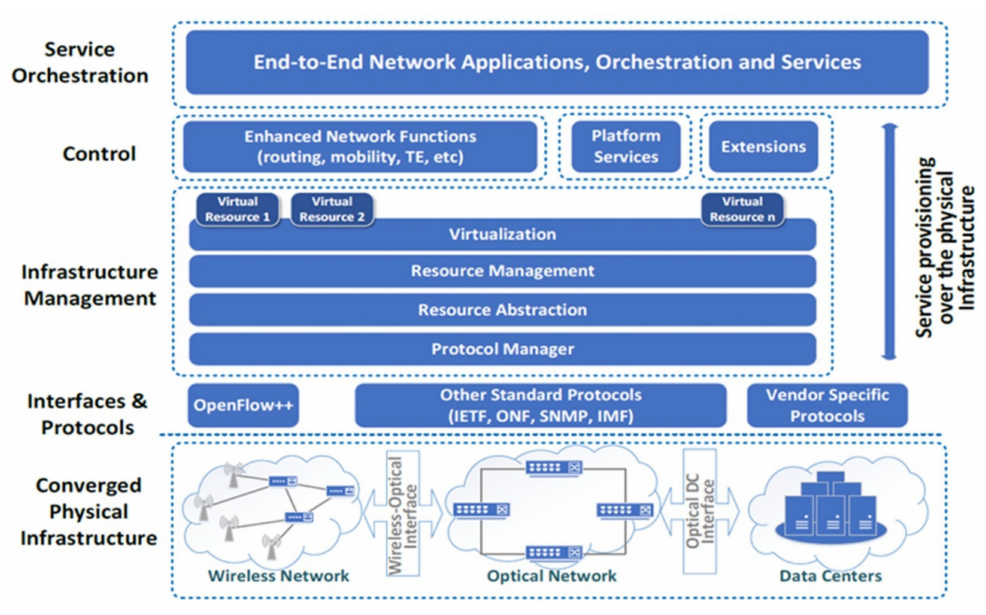
Figure 2. The generic TOUCAN architecture. TE: tra ffi c engineering, IETF: internet engineering task force, ONF: open networking foundation, SNMP: simple network management protocol, IMF: internet message